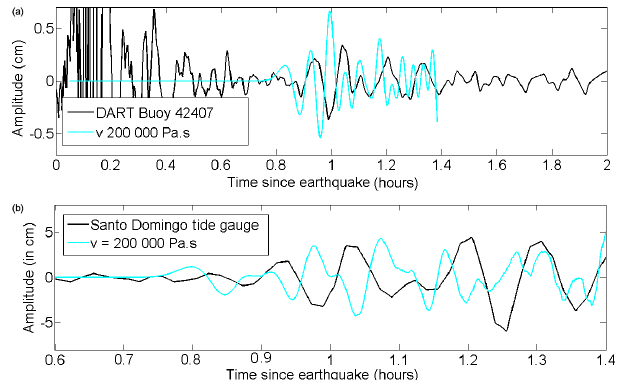
Figure 10. Comparison between observed and simulated wa- ter heights at the Santo Domingo tide gauge (a) and at DART buoy 42407 (b) for a dynamic viscosity v = 2 × 10 5 Pas. High am- plitudes observed before 0.6h are due to the earthquake detected by the DART